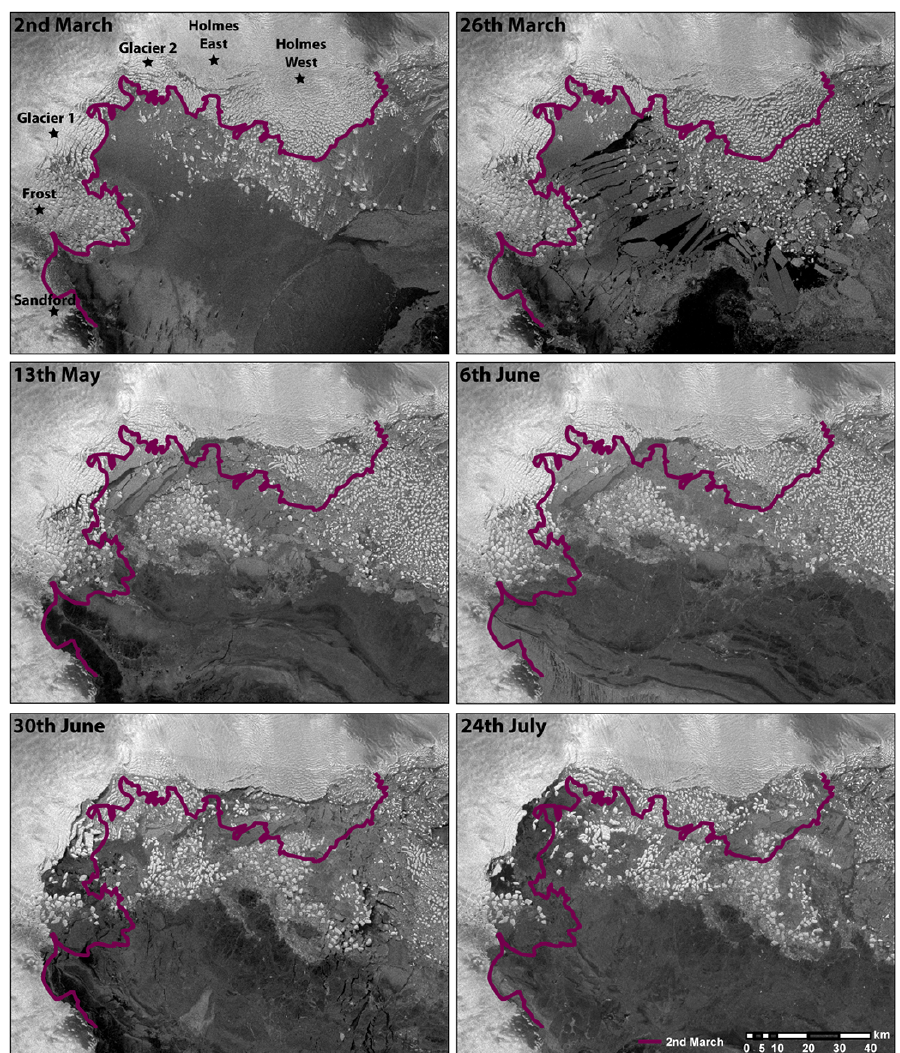
Figure 6. Sentinel-1 imagery showing the evolution of the 2016 calving event. Purple line shows the terminus position from 2 March on all